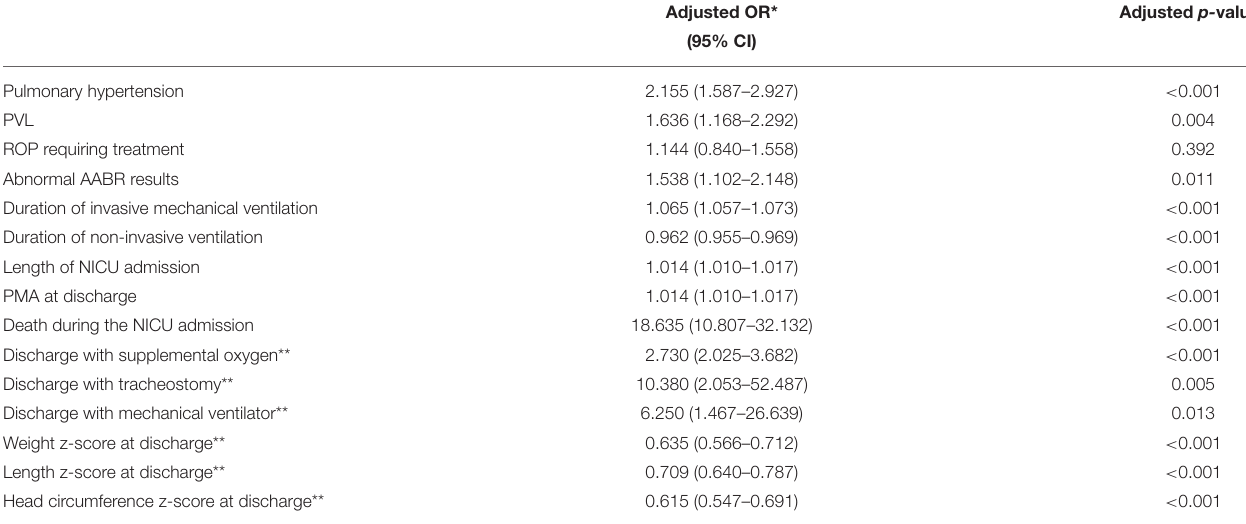
TABLE 3 | Adjusted odds ratios and p -values for comorbidities and clinical burden of type 2 severe BPD compared to those of type 1 severe